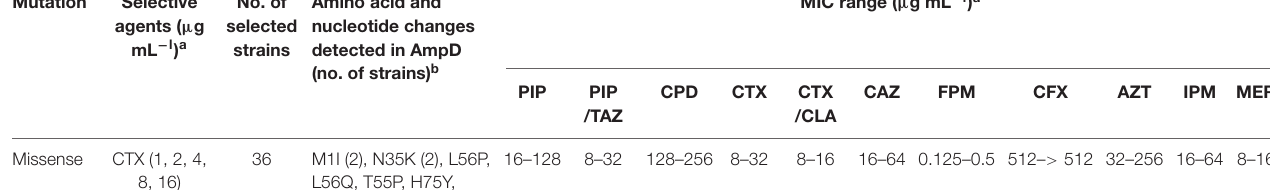
TABLE 3 | Amino acid and nucleotide changes in AmpD of ceftazidime- or cefotaxime-resistant mutants of E. ludwigii NR1491 and their antimicrobial susceptibilities. Mutation Selective agents ( µ g